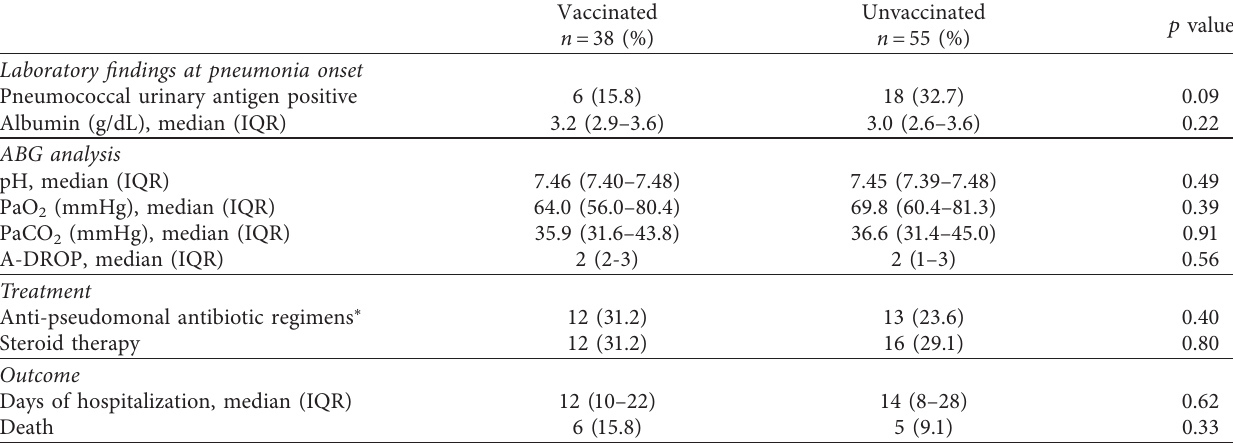
Table 2: Comparison of pneumococcal vaccinated and unvaccinated patients.